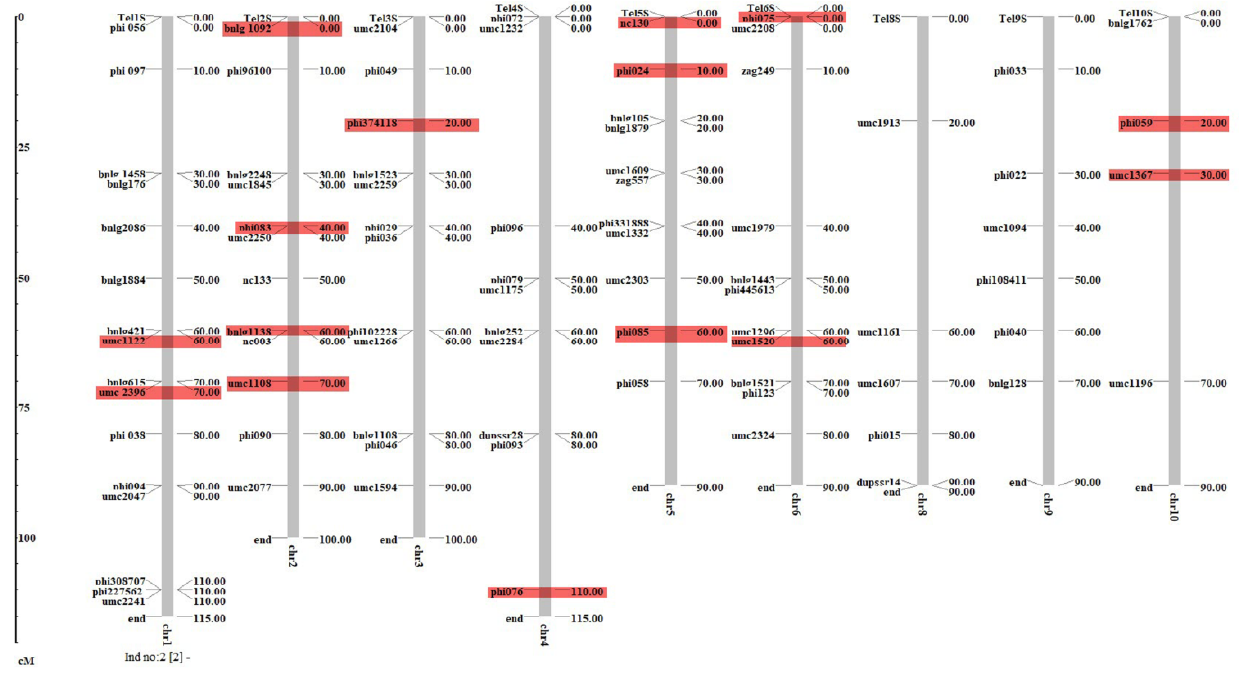
Figure 4. Chromosomal localization of polymorphic SSRs used for genotyping of 288 diverse lines. No polymorphic markers were found on Chr 7. The marker highlighted in red colors were found associated with TLB resistance. The details of all these markers have been given in Tables 3 and S1.